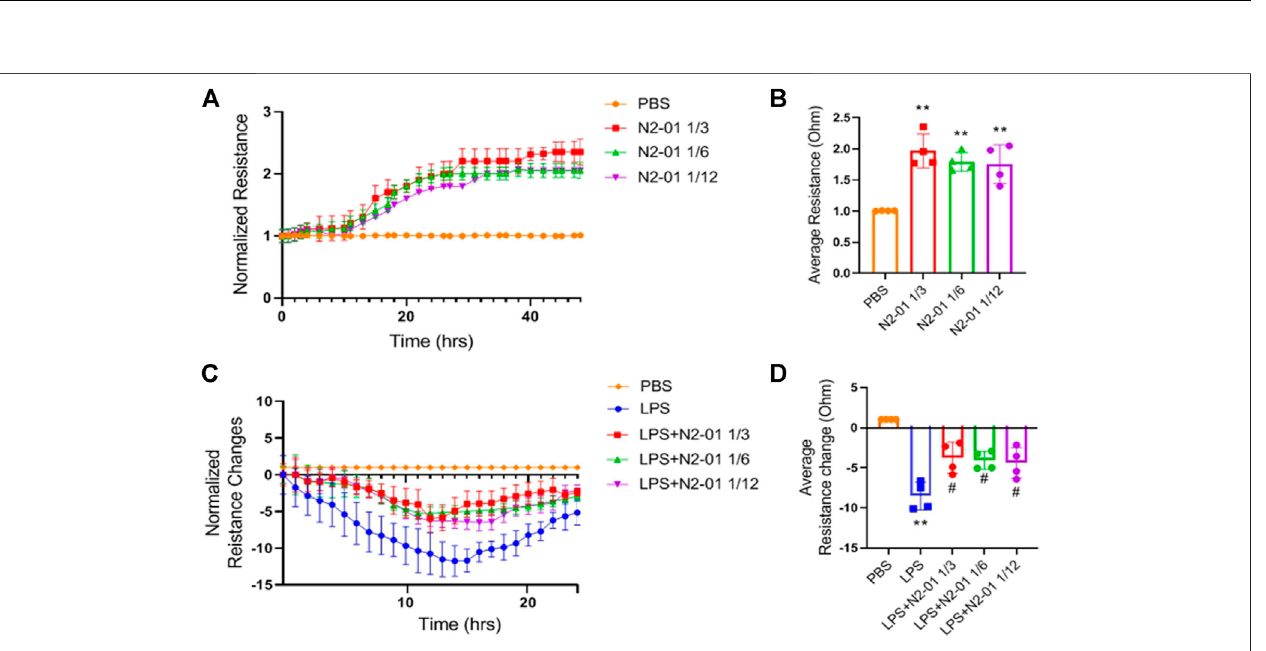
Frontiers in Pharmacology |